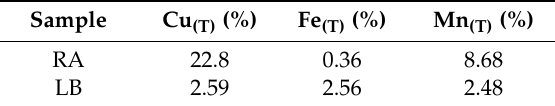
Table 1. Chemical composition of black oxide samples.